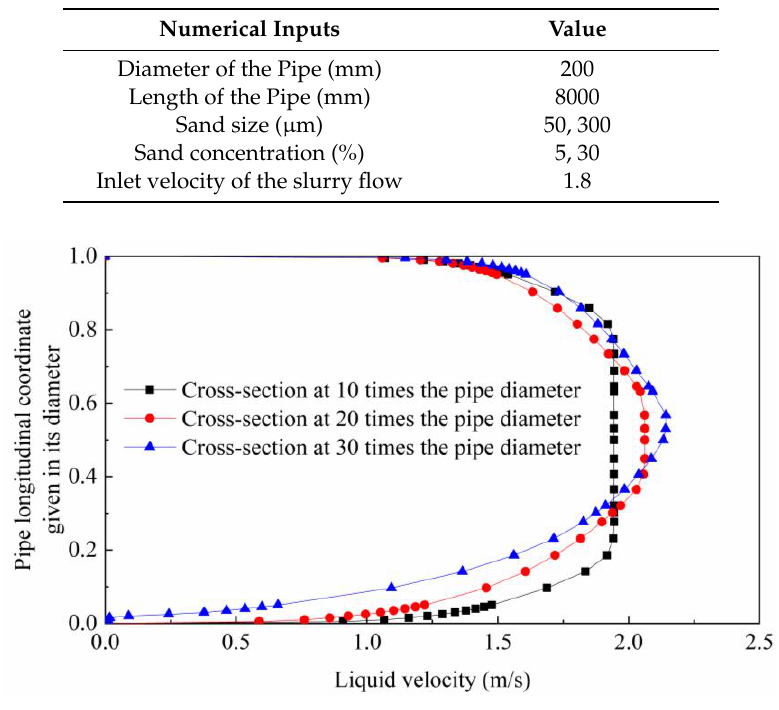
Figure 4. Liquid velocity at different cross-sections, v in = 1.8 m/s, d = 50 µm, c = 5%.